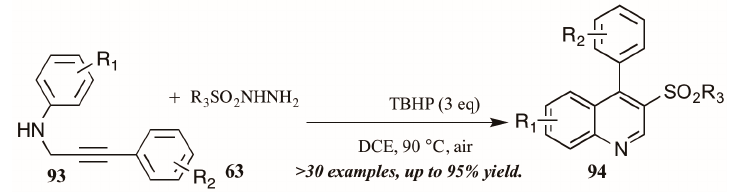
Figure 41. Oxidative cyclization to provide 3-arylsulfonylquinolines